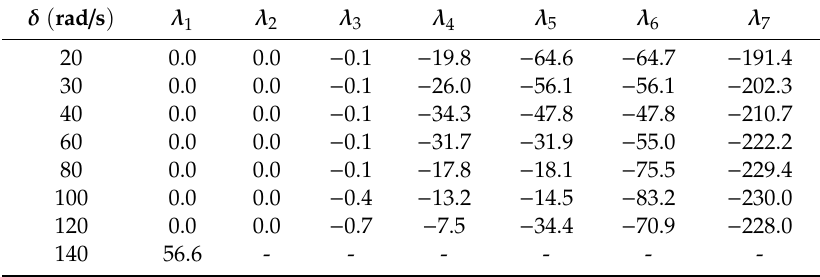
Table 4. Numerical results of LEs for admittance unilateral teleoperation as δ